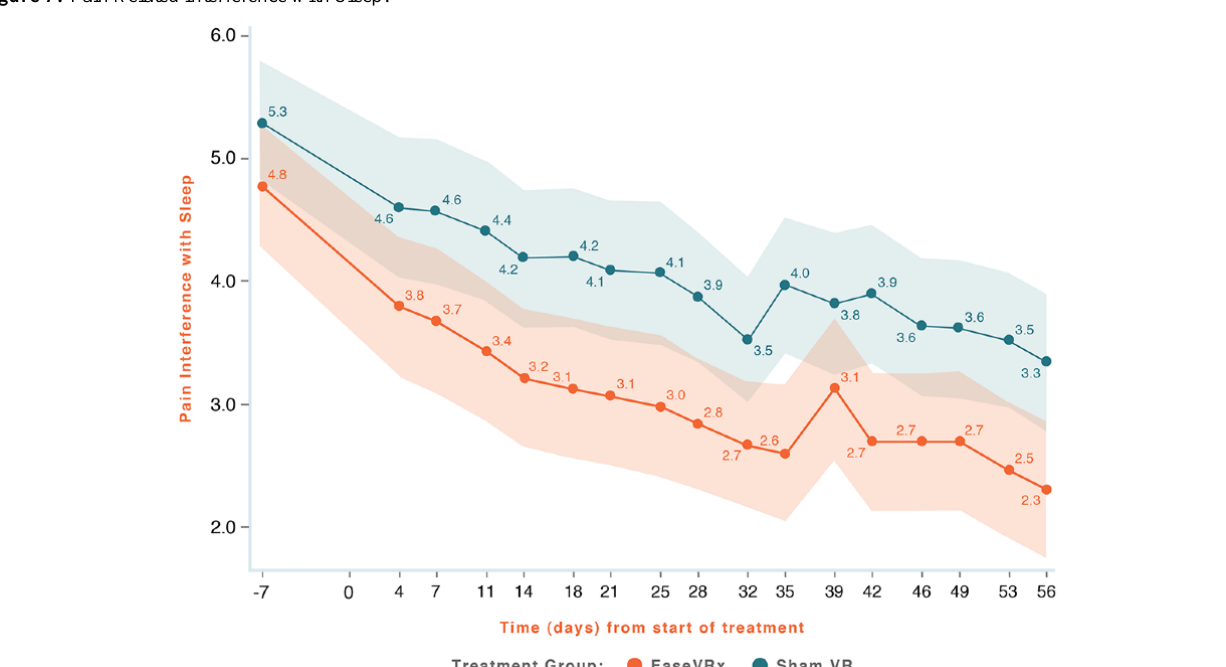
Figure 7. Pain Related Interference with